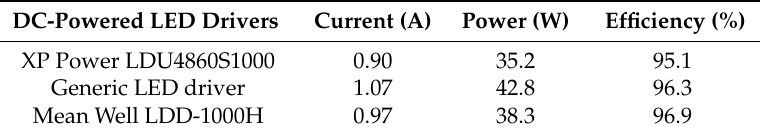
Table 2. Operating current, power and efficiency results of the DC-powered LED